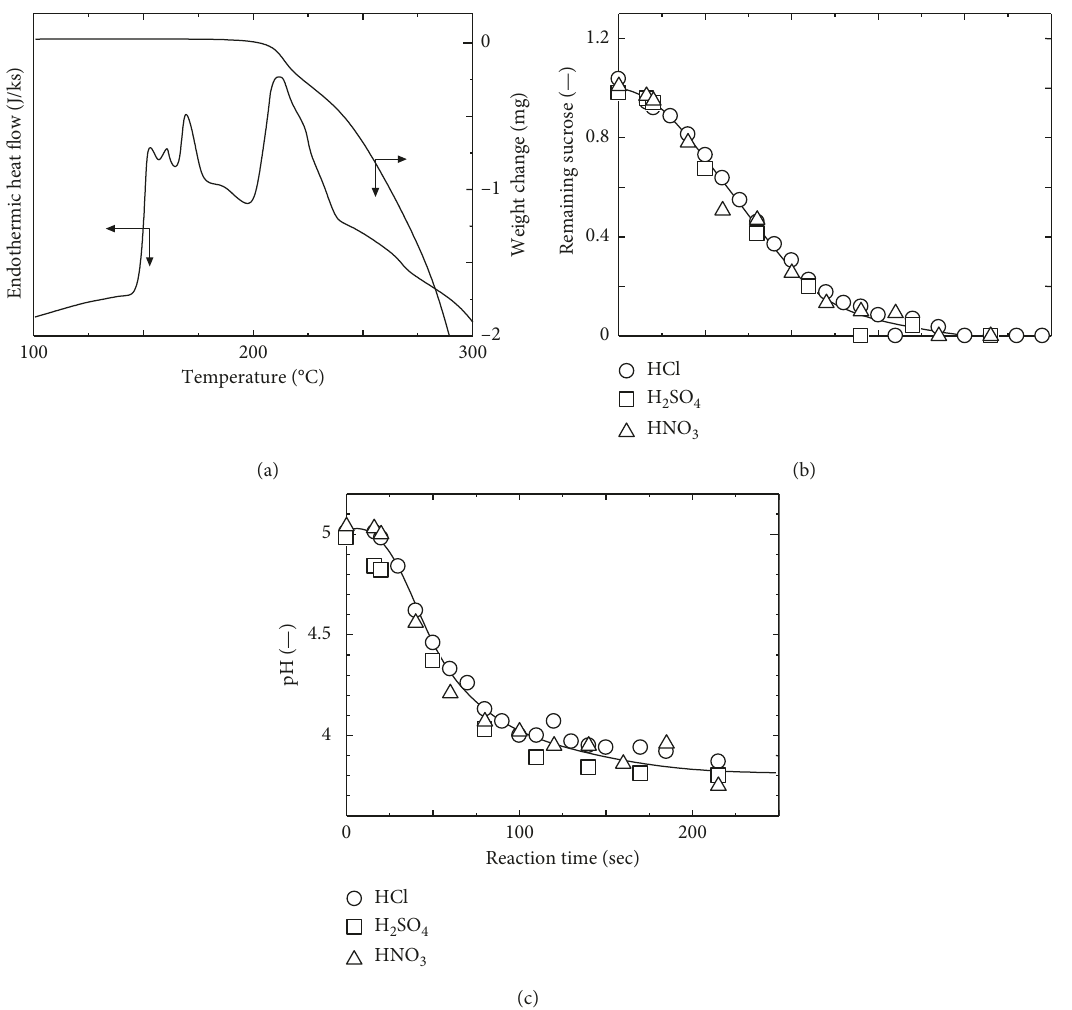
Figure 2: (a) Thermal gravimetric and differential thermogram of sucrose. Effect of acids on sucrose decomposition under the subcritical water condition. Time course of (b) remaining sucrose concentration and (c) pH. All the experiments were performed at 185 ° C, 10MPa, initial pH 5, and C 0 �